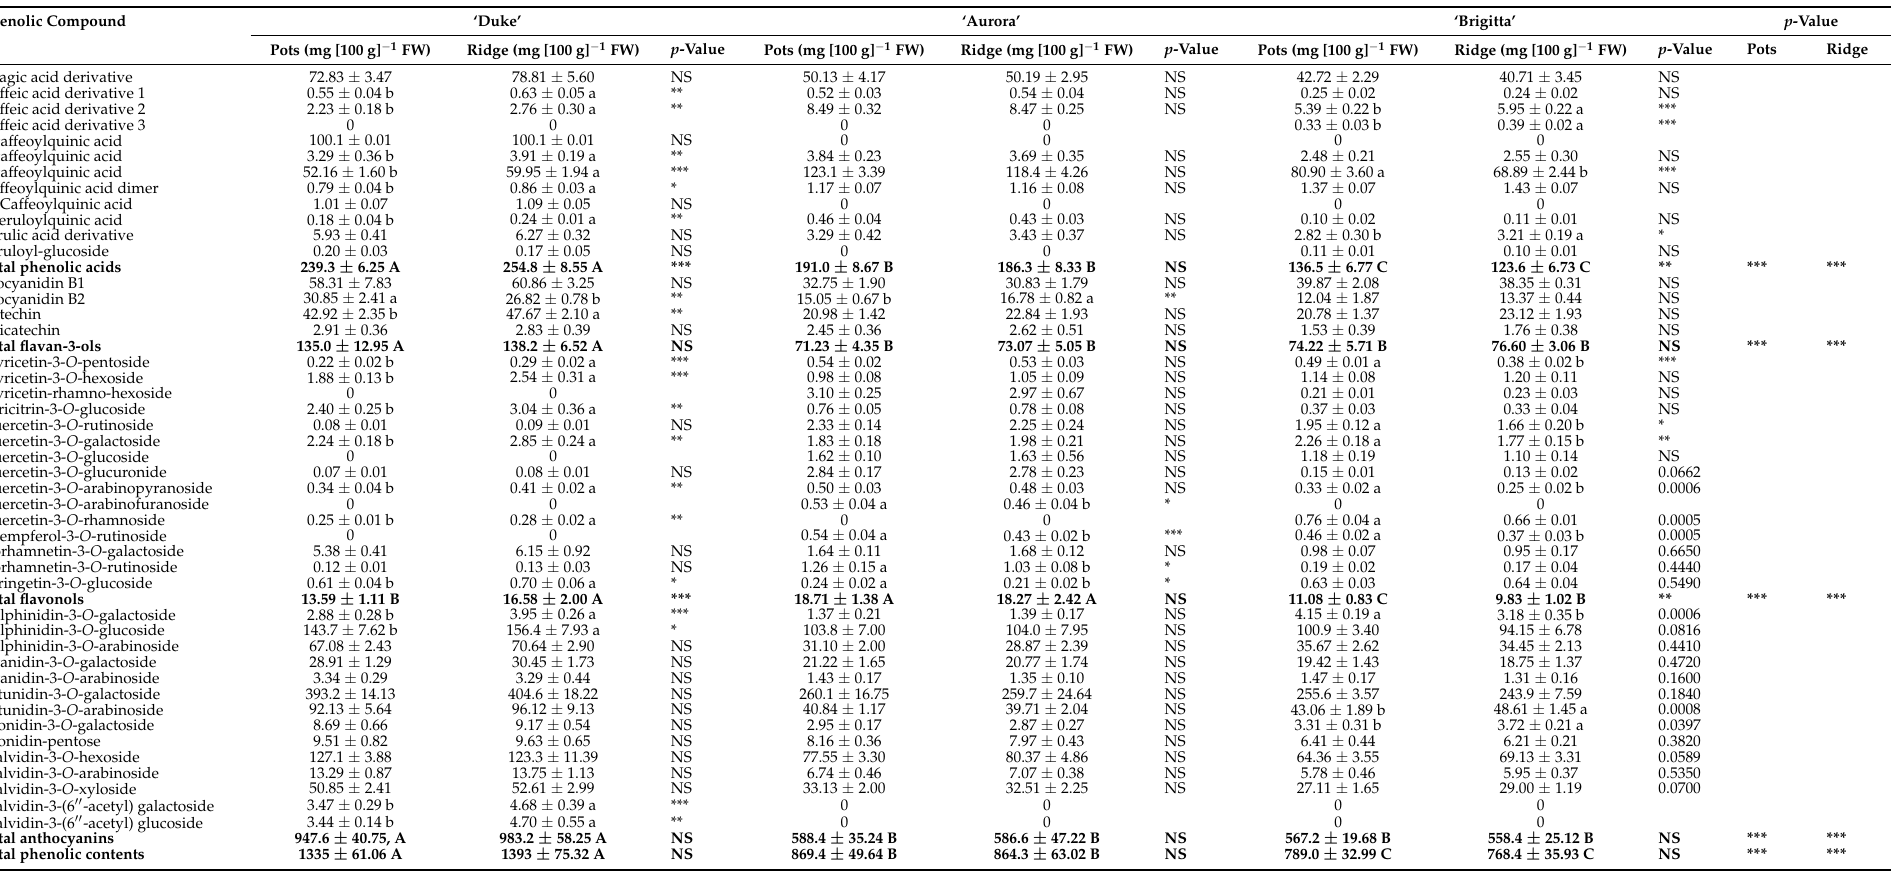
Data are the mean ± standard error of five replicates. Different lowercase letters indicate statistically significant differences between planting methods within cultivar and uppercase letters between cultivars within planting method (LSD tests, α < 0.05). * p < 0.05; ** p < 0.01; *** p < 0.001; NS, not significant. FW, fresh